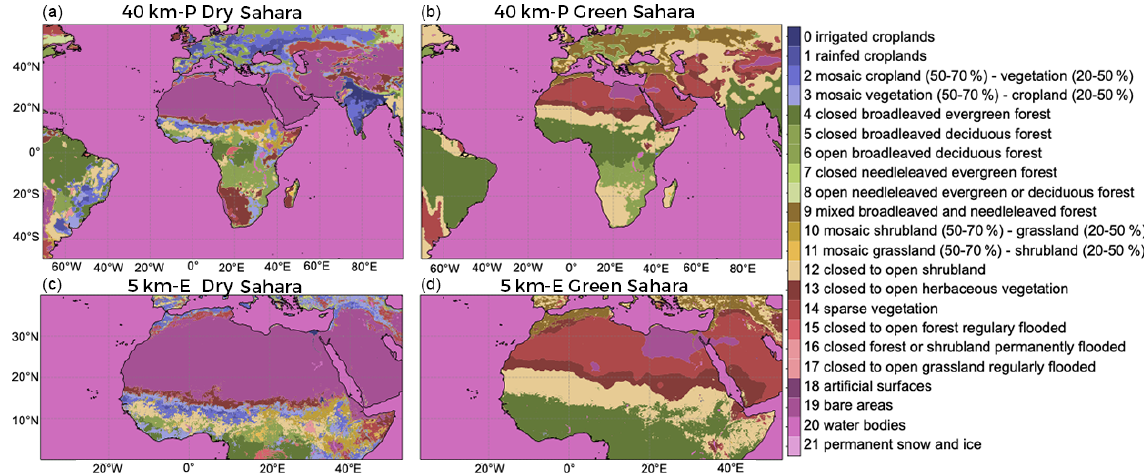
Figure 2. Land-surface cover for the Dry Sahara (a, c) and Green Sahara (b, d) simulations for the 40 and 5km simulations, respectively.